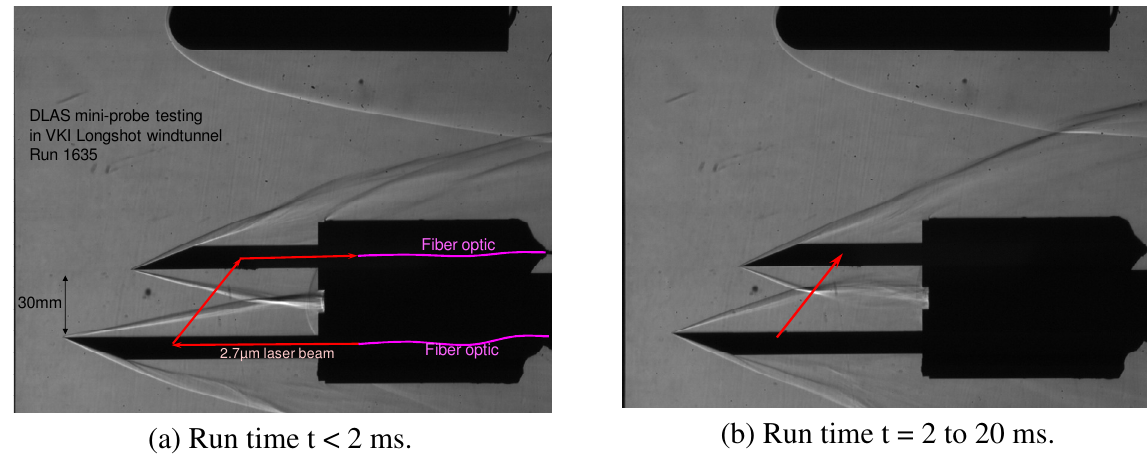
Figure 6. Schlieren images of the probe during VKI Run 1635 with optical beam path shown in red.